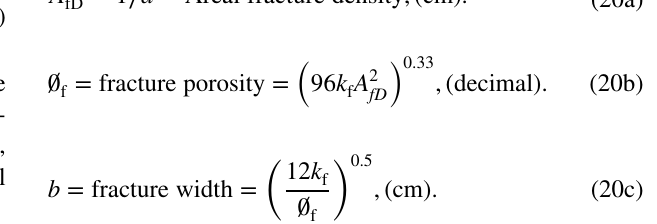
matrix permeability = 0.01 md oil viscosity at reservoir conditions = 0.5